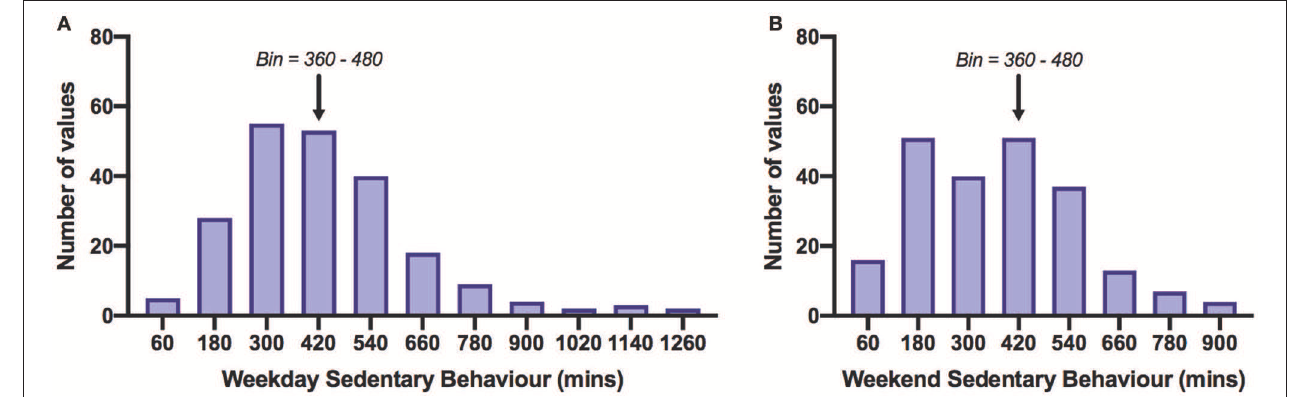
FIGURE 3 | Frequency distribution of daily sedentary behavior time on weekdays (A) and weekends (B) . All bins above the arrows are those acquiring more than 8 h/day (480 min/day) of sedentary behavior. Of all participants, 27% exceeded 480 min/day on weekdays and 32% on weekends. The overall mean SB time across weekdays and weekends was 401.8 min/day. Bin width = 120.